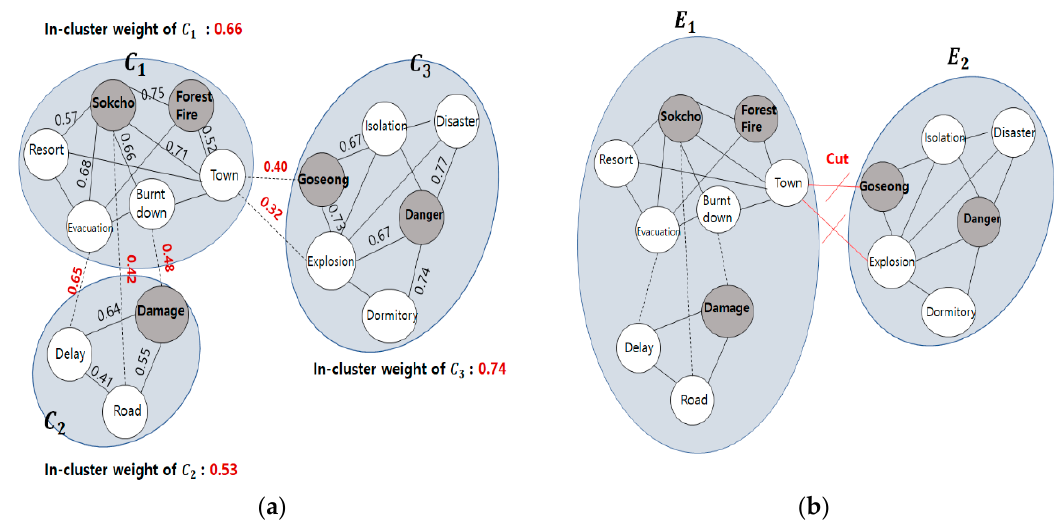
Figure 6. Example of detecting local events: ( a ) clustering; ( b ) detecting local events by merging and splitting clusters.